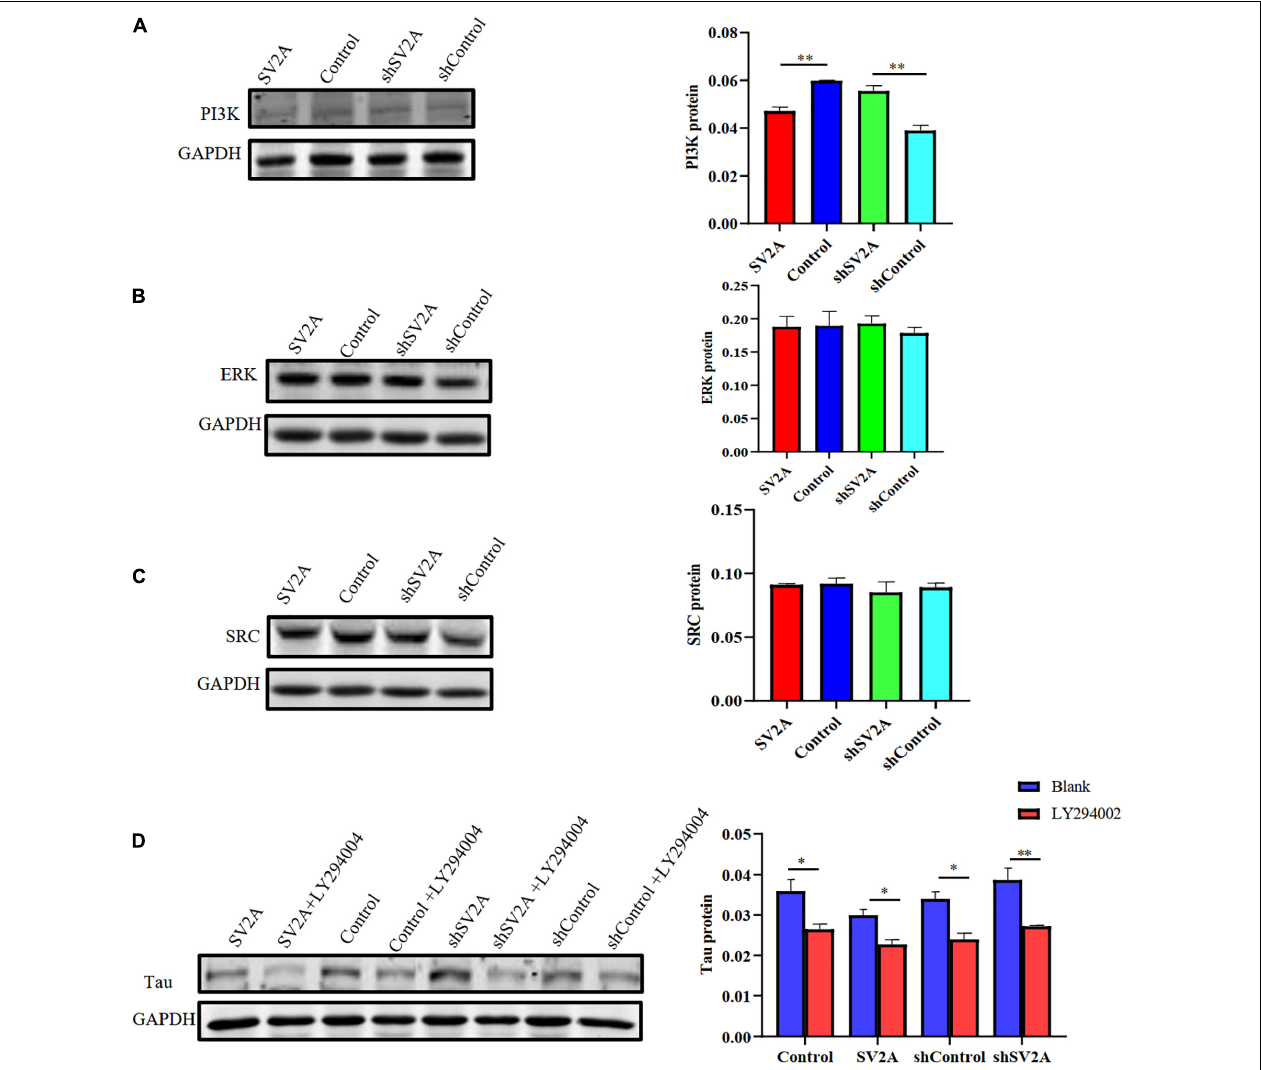
FIGURE 5 | Overexpressing of SV2A inhibits the PI3K signaling pathway. (A) Western blotting detection of PI3K protein expression levels in APPswe293T cells from the following four groups: control, cells infected with the SV2A-overexpressing virus (SV2A), shControl, and cells infected with the SV2A-silencing virus (shSV2A). The gray density was normalized to the mean gray density of Gapdh. (B) Western blotting detection of ERK protein expression levels in APPswe293T cells from the following four groups: control, cells infected with the SV2A-overexpressing virus (SV2A), shControl, and cells infected with the SV2A-silencing virus (shSV2A). The gray density was normalized to the mean gray density of Gapdh. (C) Western blotting detection of SRC protein expression levels in APPswe293T cells from the following four groups: control, cells infected with the SV2A-overexpressing virus (SV2A), shControl, and cells infected with the SV2A-silencing virus (shSV2A). The gray density was normalized to the mean gray density of Gapdh. (D) Comparison of western blotting detection of tau protein expression levels in APPswe293T cells and APPswe293T cells with LY294002 (PI3K signaling pathway inhibitor) from the following four groups: control, cells infected with the SV2A-overexpressing virus (SV2A), shControl, and cells infected with the SV2A-silencing virus (shSV2A). The gray density was normalized to the mean gray density of Gapdh. For each group of APPswe293T cells, n = 3. Data are expressed as mean ± SEM. One-way analysis of variance (ANOVA). ∗ p < 0.05. ∗∗ p <